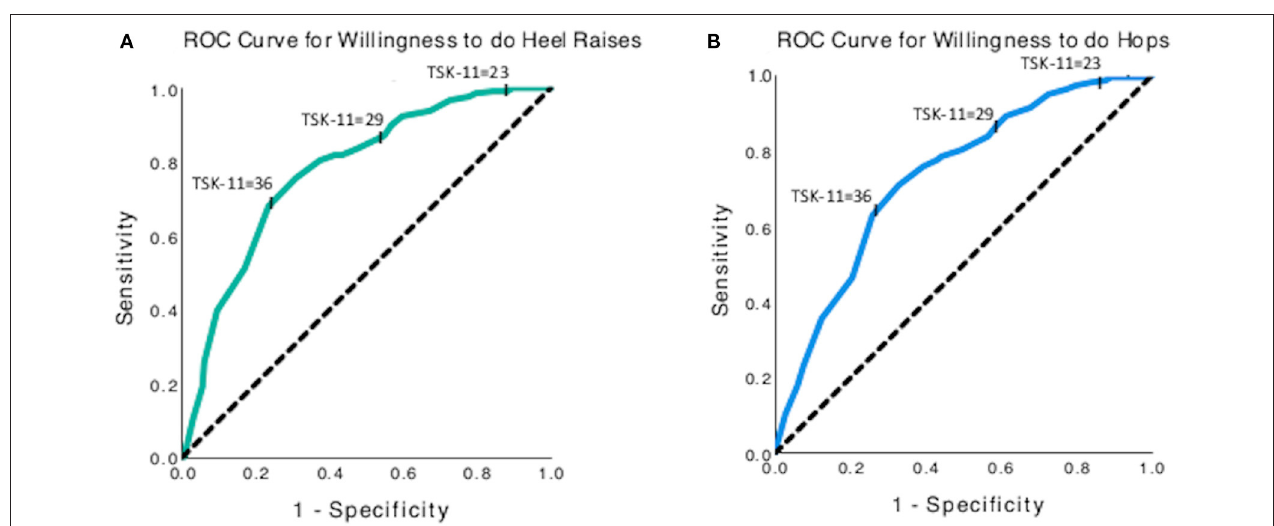
FIGURE 6 | Receiver operating curves for using the TSK-11 score to predict willingness to complete (A) single leg heel raises, and (B) single leg hops. The y-axis represents sensitivity, and the x-axis represents (1-specificity).